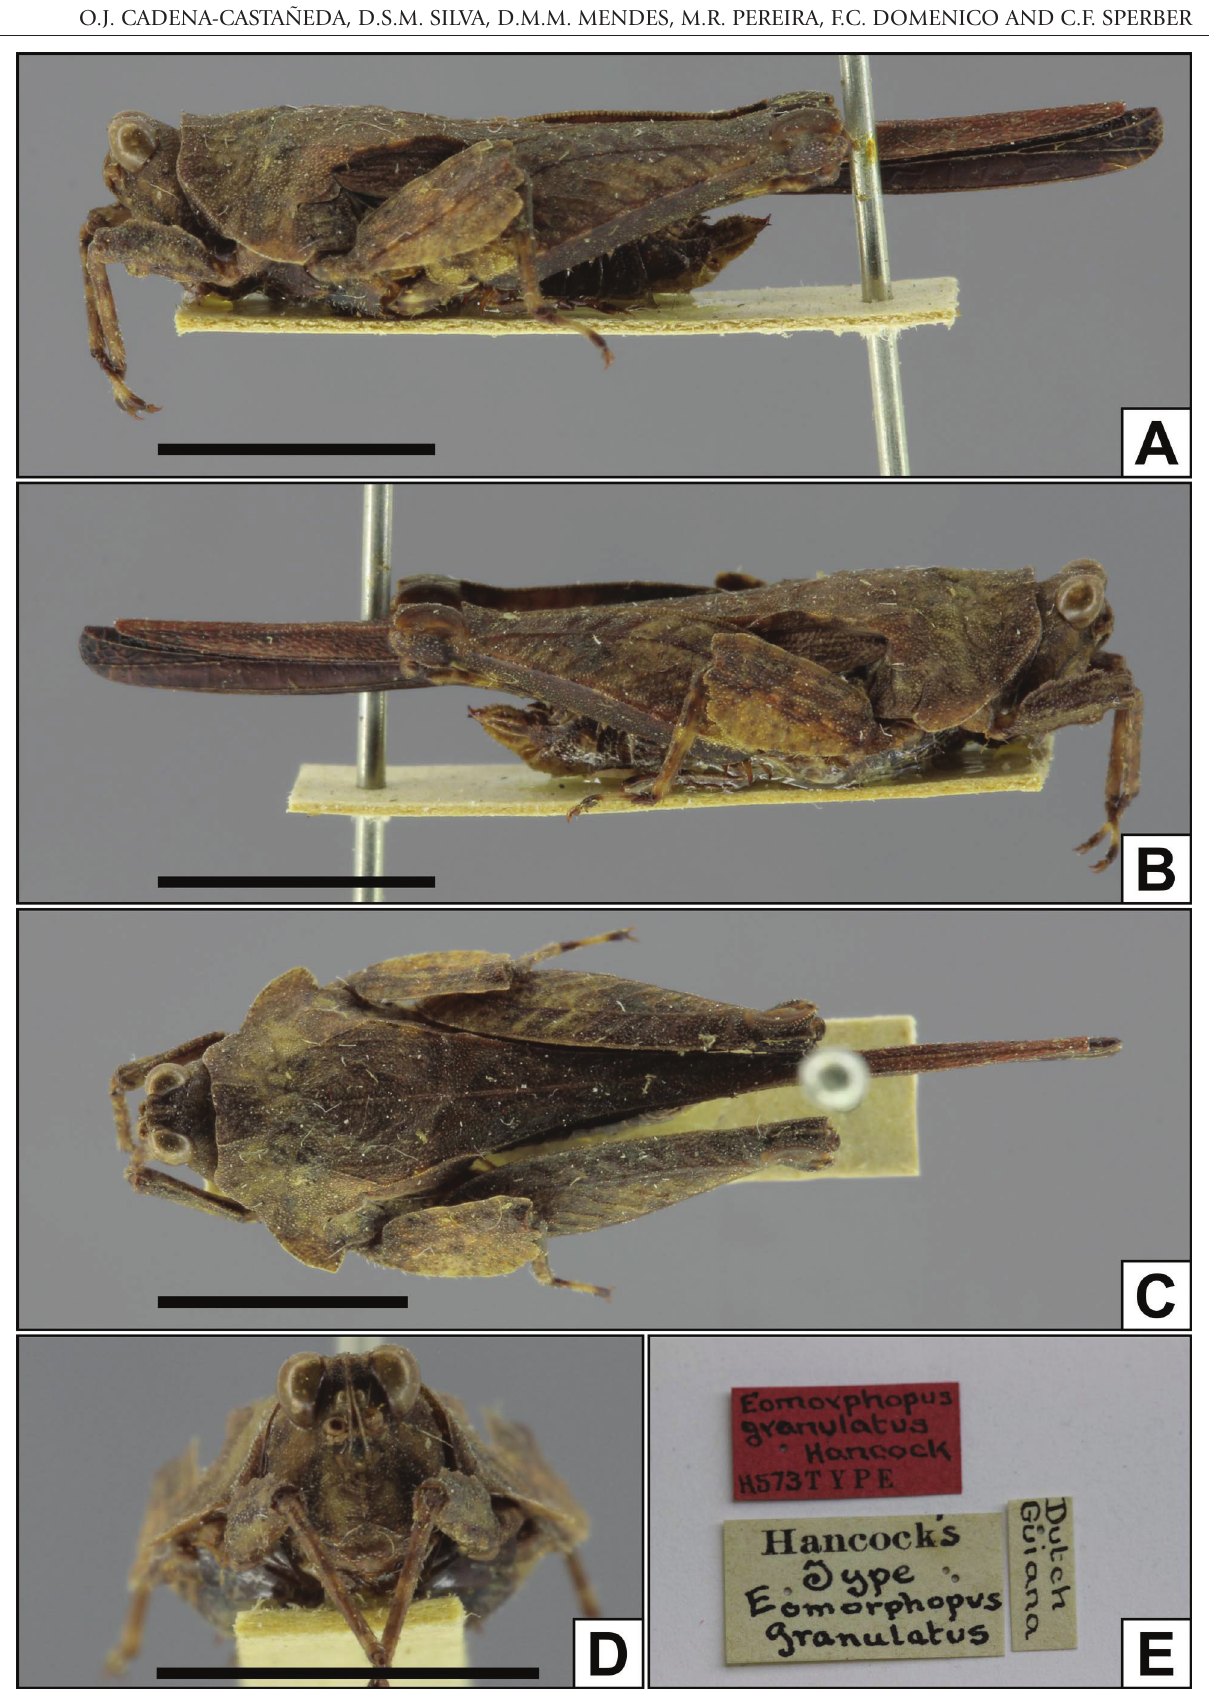
Fig. 4. Eomorphopus granulatus (female lectotype) A. Lateral left habitus; B. Lateral right habitus; C. Dorsal view; D. Head details in frontal view; and E. Labels. Scale bars: 5